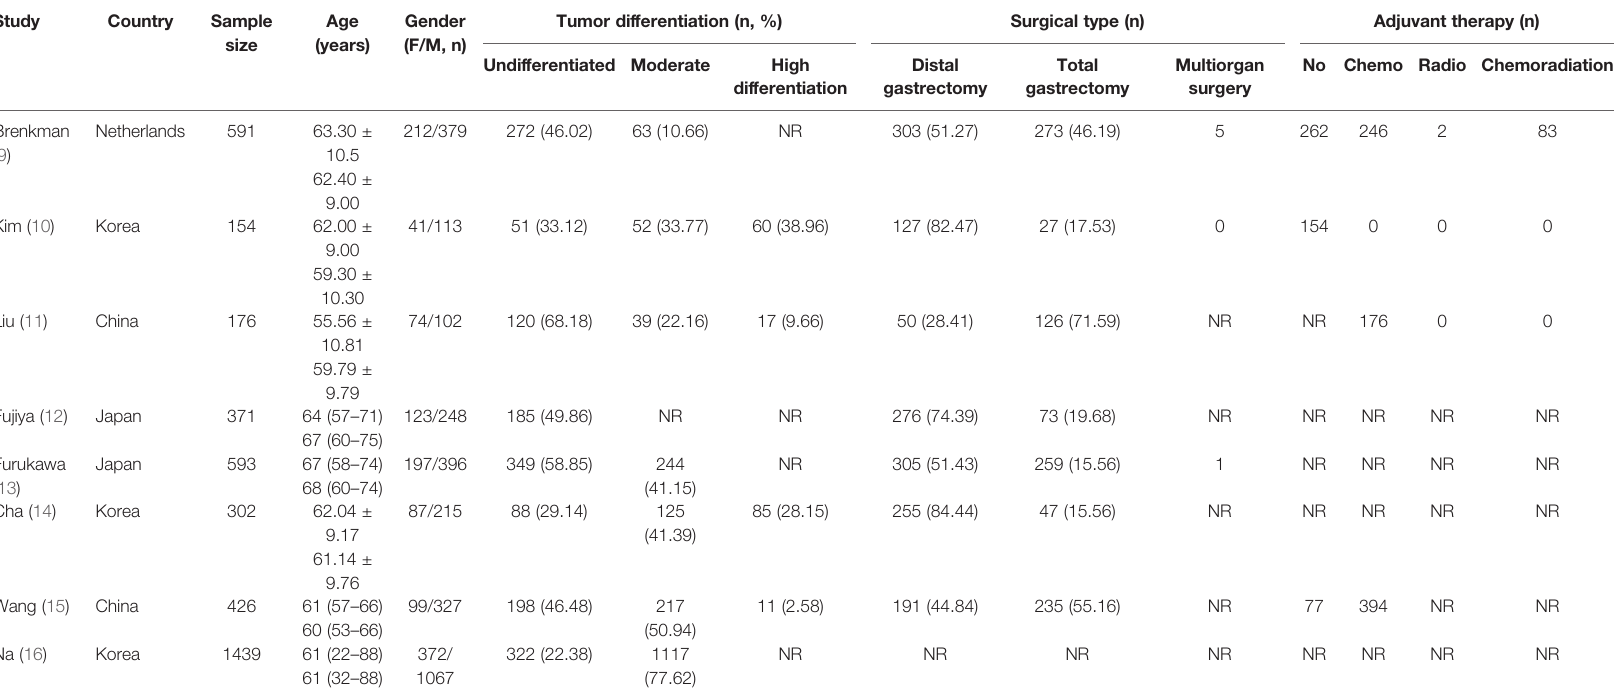
TABLE 1 | the characteristics of included